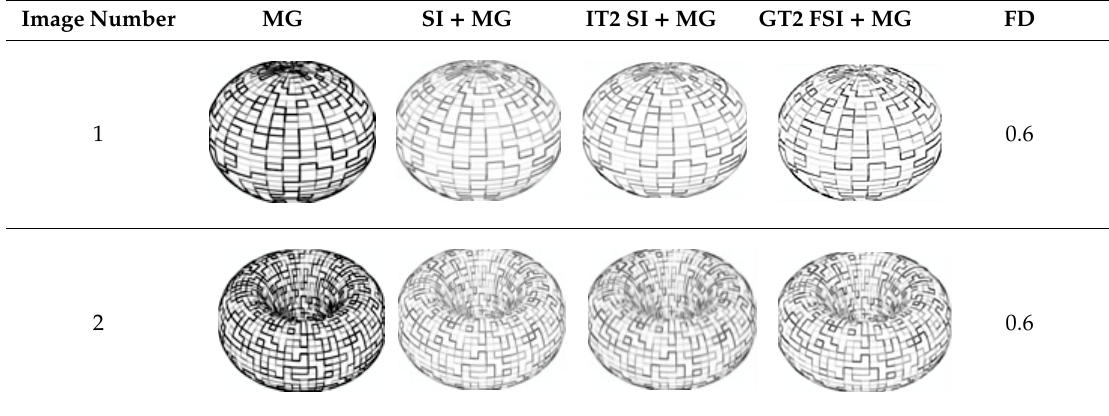
Table 9. Edge detectors in synthetic images.